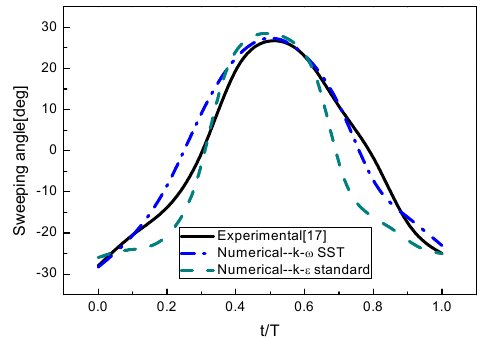
Figure 3. Sweeping angle over one period.